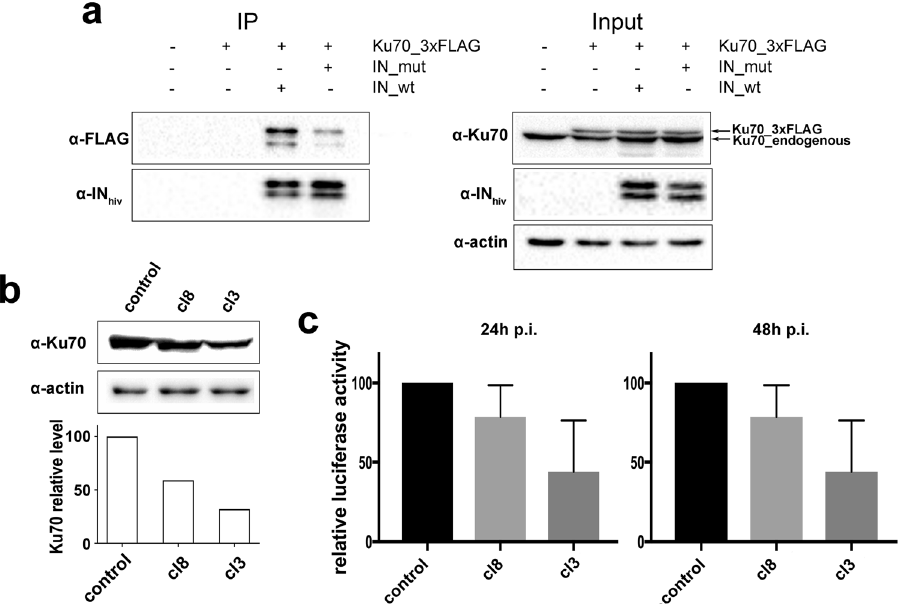
Figure 8. The interaction between Ku70 and IN and the influence of Ku70 on integration in cell culture. ( a ) Immunoprecipitation of an HA-tagged IN_WT or IN_Mut with E212A/L213A substitutions co-transfected in the HEK293T cells together with Ku70_3xFLAG. Eluates were analyzed by Western blot (left panel) with anti-FLAG antibodies to detect Ku70_3FLAG and anti-IN antibodies to detect HIV IN. 10% of the cell lysates were used for input analysis by Western blot (right panel) with anti-Ku70 antibodies for the detection of Ku70 (Ku70_3xFLAG migrates slightly slower than endogenous Ku70) and anti-actin detection to be used as loading control. Cropped images are presented. Uncropped images are shown on Fig. S9. ( b ) Western blot analysis of Ku70 protein levels in HEK 293 T clones expressing either control no-target shRNA (control) or Ku70-targeting shRNA (clone 8 and clone 3). ( c ) Relative luciferase activity in control cells or two clones with reduced Ku70 levels transduced with luciferase expressing replication incompetent HIV-based vector 24 h (left panel) or 48 h (right panel) prior to analysis. Mean values and SDs of three independent experiments are